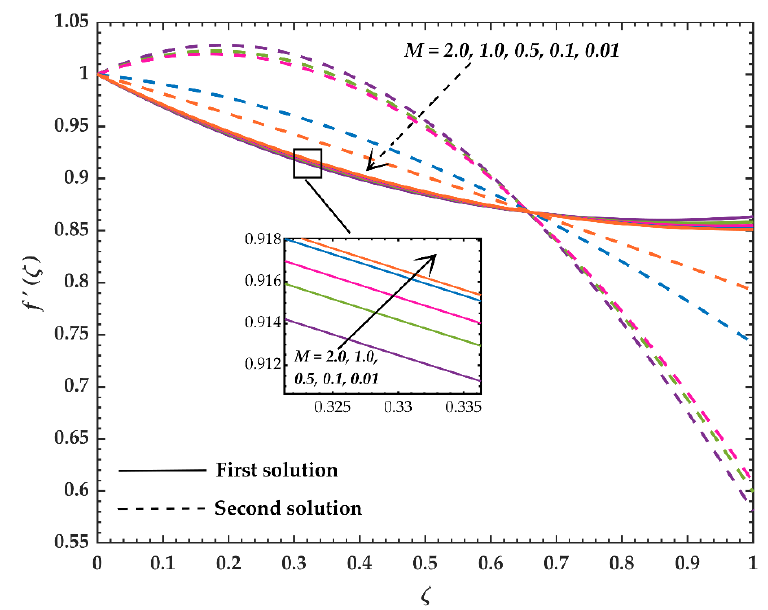
Figure 4. Velocity profiles, f (cid:48) ( ζ ) when Pr = 30, We = 0.2, n = 0.6, S = − 0.3 and σ = 1.2 as M varies.